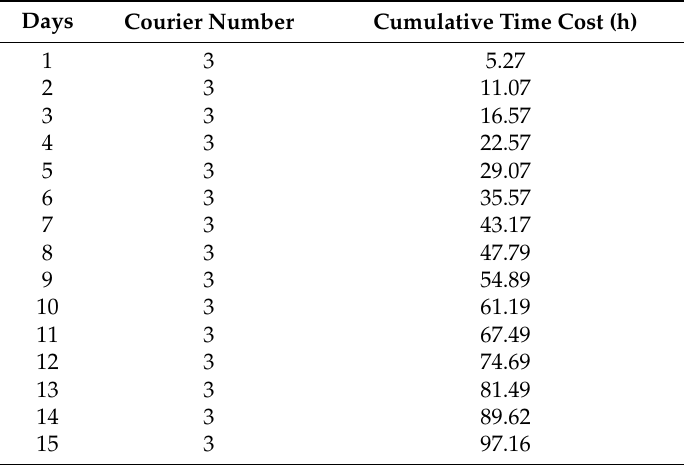
Table 5. Courier 3 cumulative time cost.